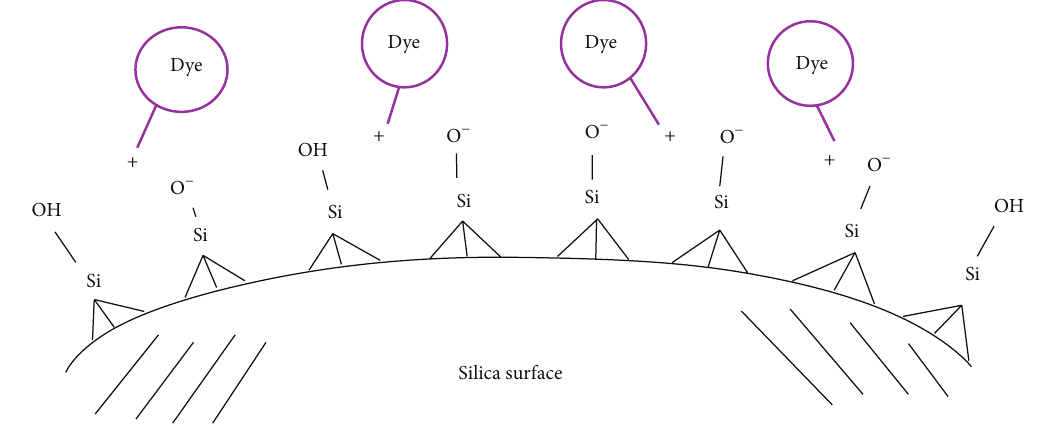
Figure 2: Electrostatic interaction of CV and sorbent.